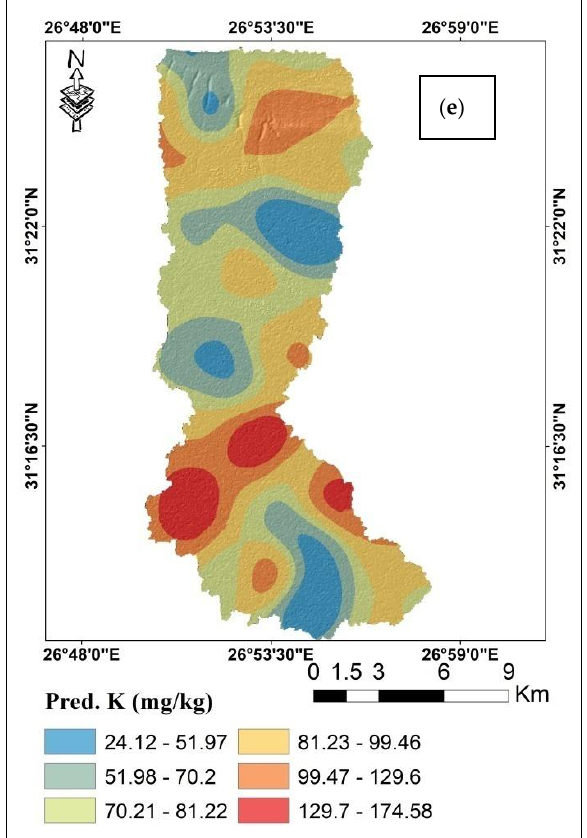
Figure 10. Spatial distribution of predicted SOC parameters: ( a ) pH, ( b ) soil organic matter %, ( c ) nitrogen content (ppm), ( d ) phosphorus content (ppm), and ( e ) potassium content (ppm).